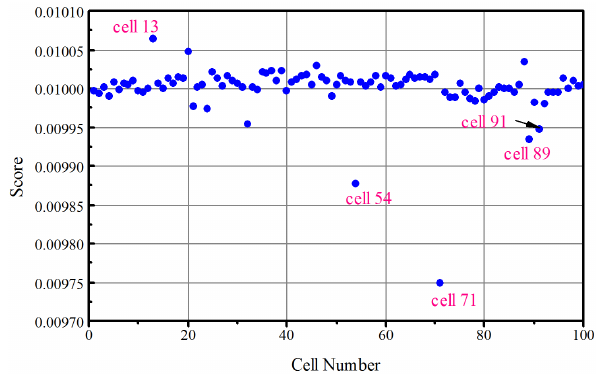
Figure 9. Score of all cells for Vehicle 2.